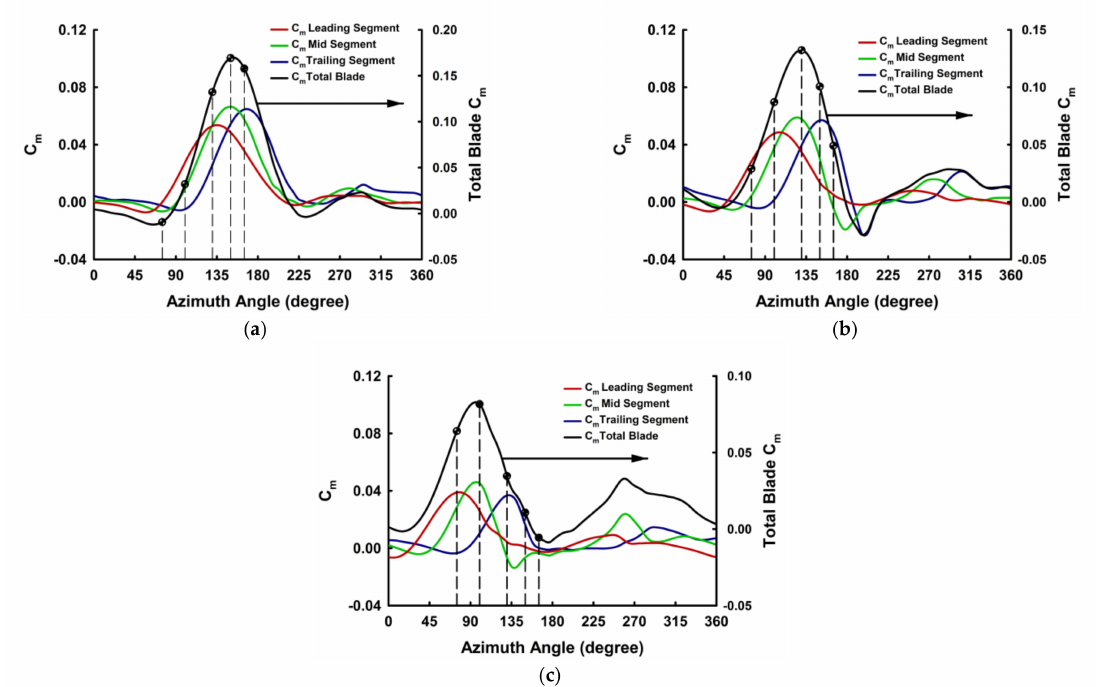
Figure 16. Section-wise C m contribution of each segment of a single blade of ( a ) ϕ = 60 ◦ , ( b ) ϕ = 90 ◦ , and ( c ) ϕ = 120 ◦ helical-bladed VAWT operating at a TSR of